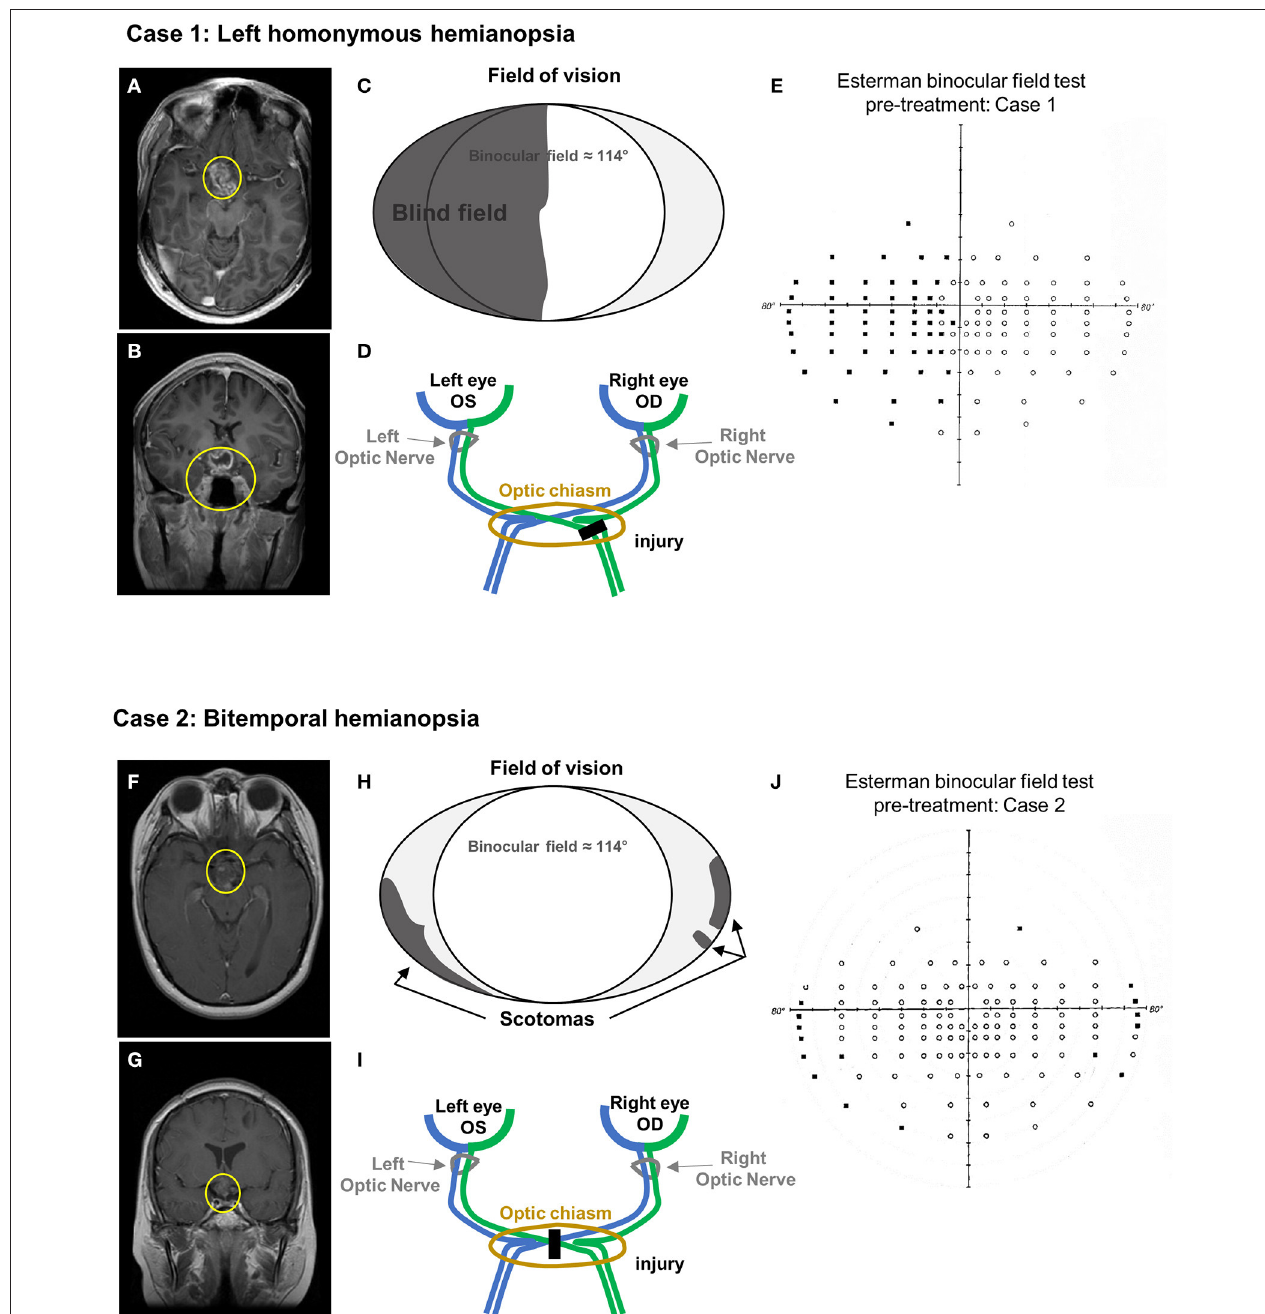
FIGURE 1 | Case presentation. (A–E) Case 1 MRI axial (A) and coronal (B) view (T1 + contrast). Yellow circles indicate the remaining tumor mass after chemotherapy. (C) Schematic of the visual field defects. (D) Diagram of the optic pathway indicating the location of the injury. (E) Esterman binocular field test at baseline (pre-treatment). Black dots correspond to unseen point of light. (F–J) Case 2 MRI axial (F) and coronal (G) view (T1 + contrast). Yellow circles indicate the remaining tumor mass after chemo- and focal radiotherapy. (H) Schematic of the visual field defects. (I) Diagram of the optic pathway indicating the location of the injury. (J) Esterman binocular field test at baseline (pre-treatment). Black dots correspond to unseen point of light.